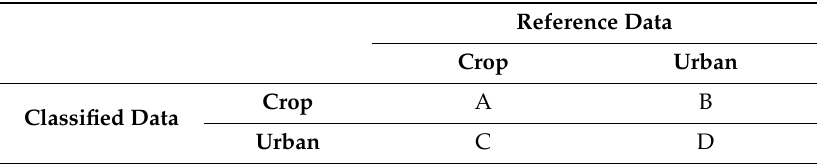
Table 3. Example layout of a confusion